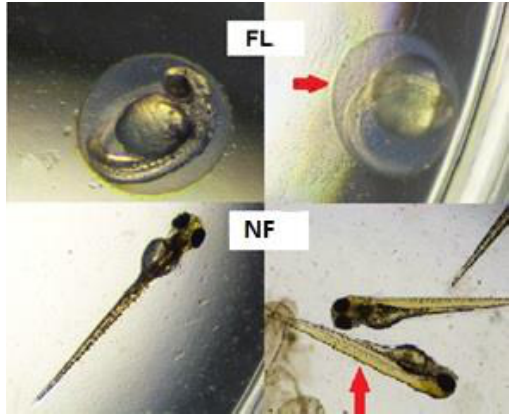
Figure 2. Illustrative examples of pigmentation anomalies found at 32 hpf for FL (fluoxetine) and at 80 hpf for NF (norfluoxetine). Control embryos and larvae are shown in the left images; exposed embryos and larvae showing pigmentation anomalies (red arrows) are shown in the right.3.2. Gene Expression .